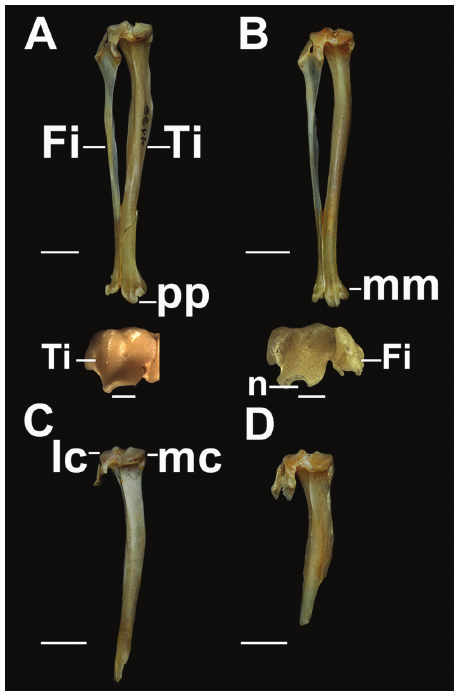
Figure 6. Caudal and distal views of the right tibia and fibula. A Tympanoctomys aureus B Tympanocto- mys barrerae C Tympanoctomys kirchnerorum D Tympanoctomys loschalchalerosorum . Fi, fibula; lc, lateral condyle; mc, medial condyle; mm, medial malleolus; n, notch; pp, posterior process; Ti, tibia. Scale bars 5 mm for all views except distal view where the scale bars are 1